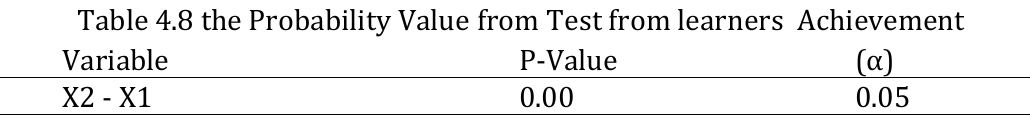
Table 4.8 the Probability Value from Test from learners